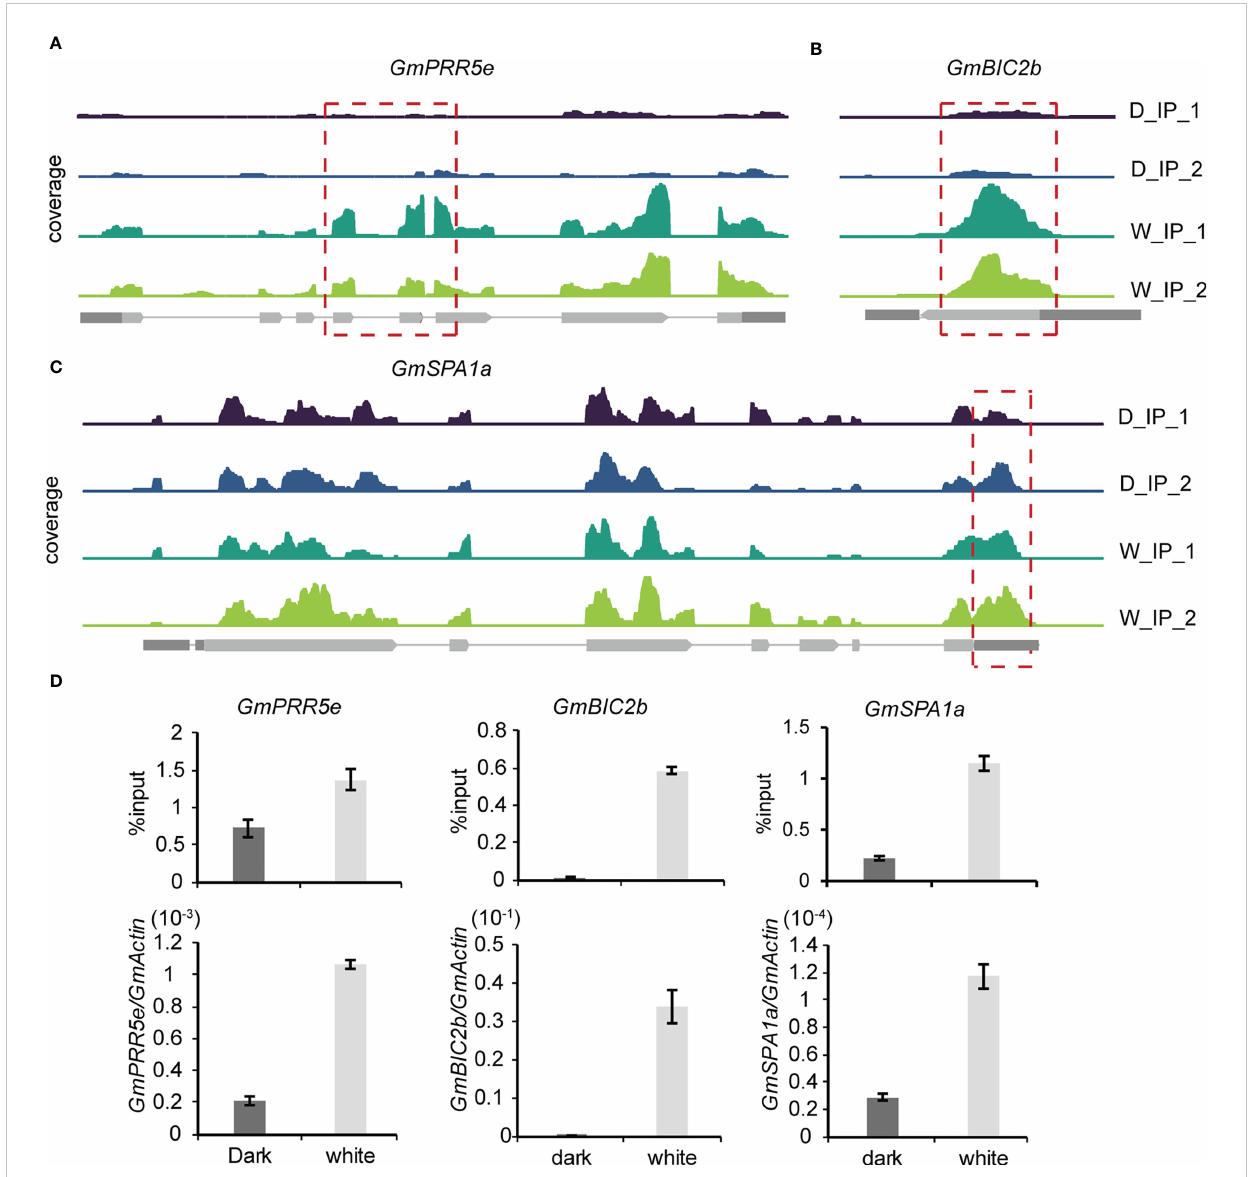
FIGURE 6 Gene expression-regulated m 6 A modi fi cation correlates with light signaling. (A – C) , Genomic visualization of m 6 A density maps of representative genes of the light signaling pathway (GmPRR5e, GmBIC2b and GmSPA1a). (D) The m 6 A abundance of individual sites of selected genes and their expression levels were analyzed by m 6 A-IP-qPCR and RT – qPCR. The values represent the means ± SD